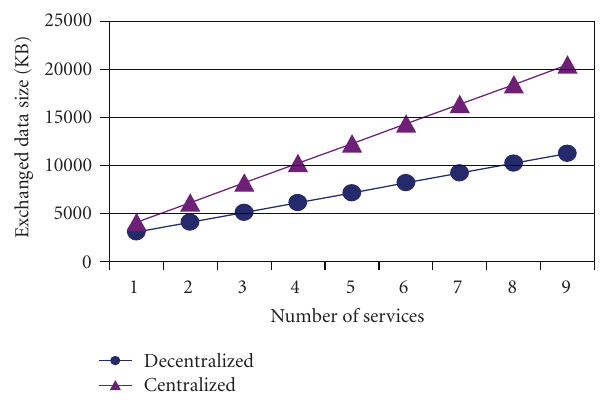
Figure 12: Exchanged data size versus number of services. (Band- width = 54Mbps, file size = 1Mbyte.)